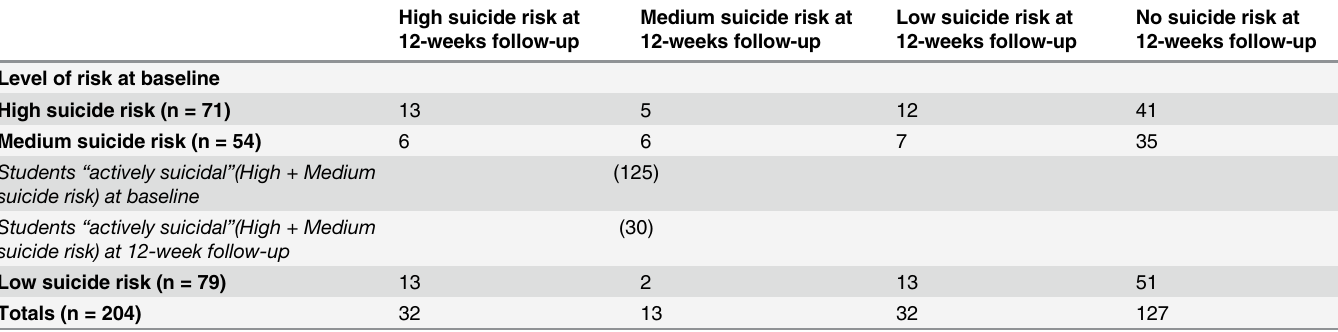
High suicide risk at Medium suicide risk at Low suicide risk at No suicide risk at 12-weeks follow-up 12-weeks follow-up 12-weeks follow-up 12-weeks follow-up